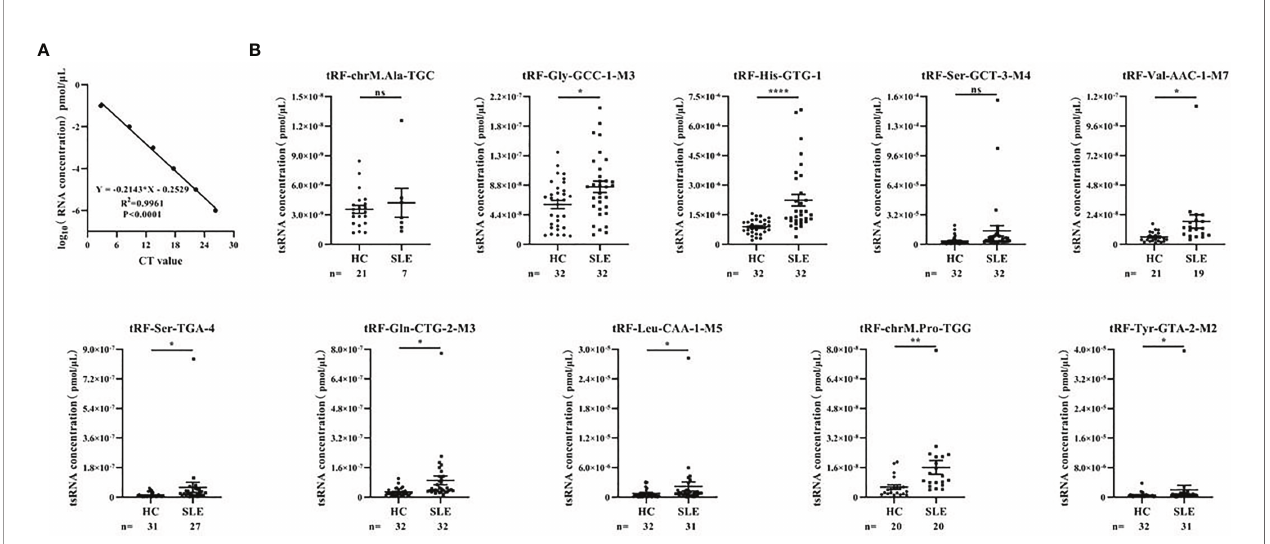
FIGURE 3 | Identi fi cation of differentially expressed serum tsRNAs in systemic lupus erythematosus (SLE) patients. (A) Standard curve of tsRNA concentration. Statistical correlation was determined by linear regression and Pearson correlation. (B) RT-qPCR veri fi cation of 10 differentially expressed tsRNA in serum of SLE without lupus nephritis (LN) group and healthy control group. Statistical signi fi cance was determined by unpaired two-tailed t-test (*P < 0.05, **P < 0.01, ****P < 0.0001). ns, Non signi fi